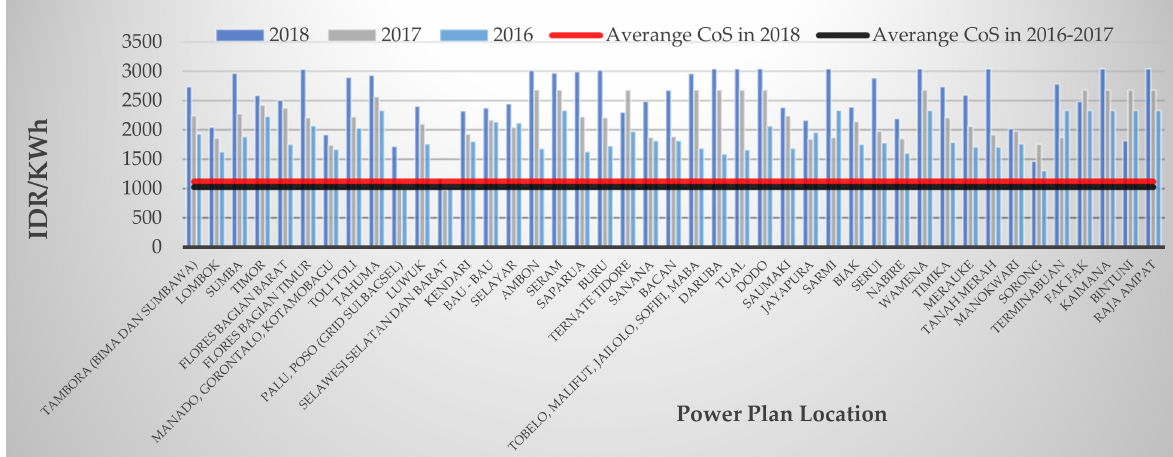
Figure 1. Comparison of Indonesian CoS to CoS Per location in Indonesia